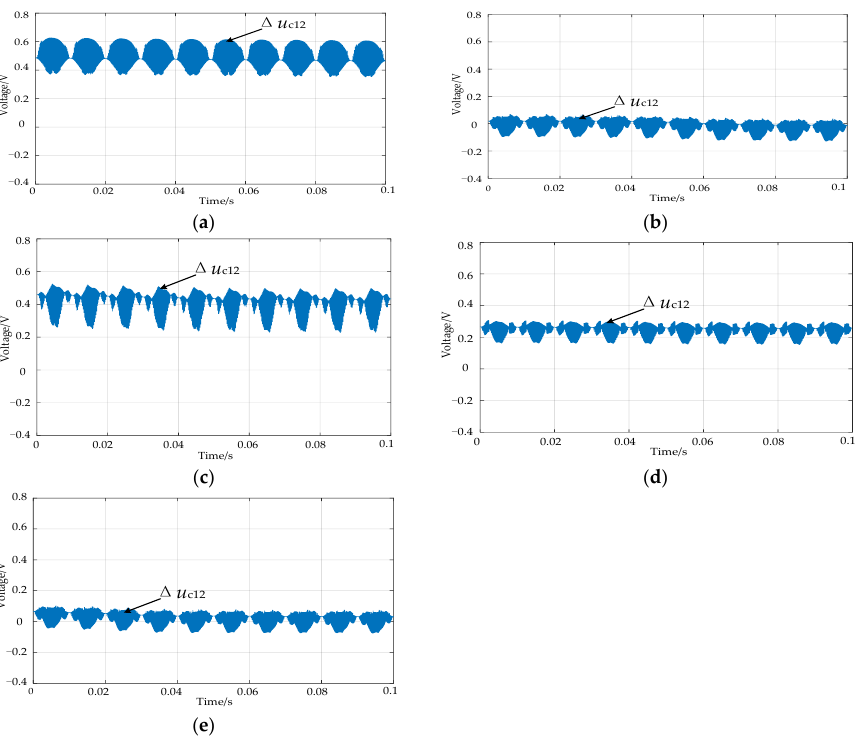
Figure 9. The voltage fluctuation of ∆ u c12 under different modulation methods during steady-state operation. ( a ) SPWM. ( b ) SVPWM - 1. ( c ) SVPWM - 2. ( d ) SVPWM - 3. ( e ) SVPWM - 4(hybrid).